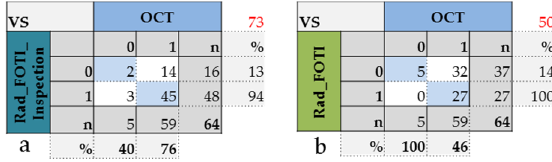
Figure 8. Contingency tables. Highest diagnostic score 1 resulting from the introduced methods radiology / fiber-optic transillumination (FOTI) / visual inspection ( a ) or from radiology / FOTI ( b ) compared to OCT (64 surfaces).